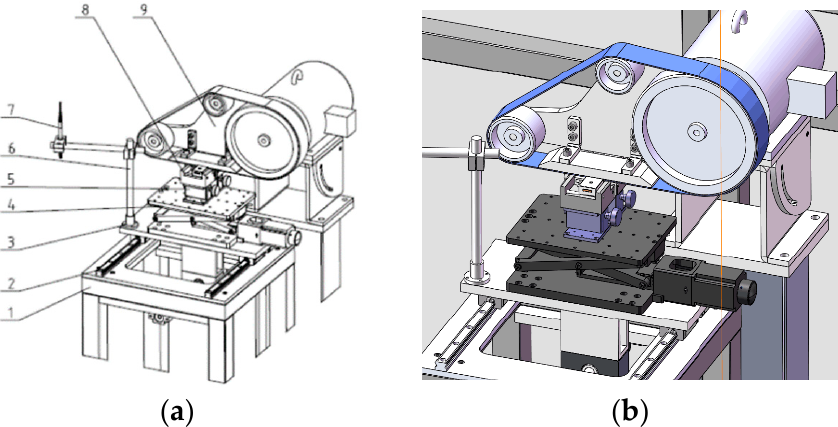
Figure 5. Schematic diagram of the friction test process of the test machine: ( a ) diagram of the complete friction-testing machine; ( b ) partial enlargement of the friction tester. 1—base;